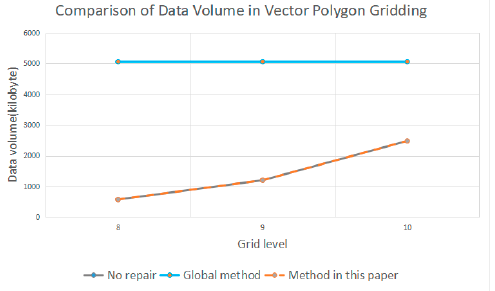
Figure 17. Comparison of the data volumes of the gridding results of the three methods.